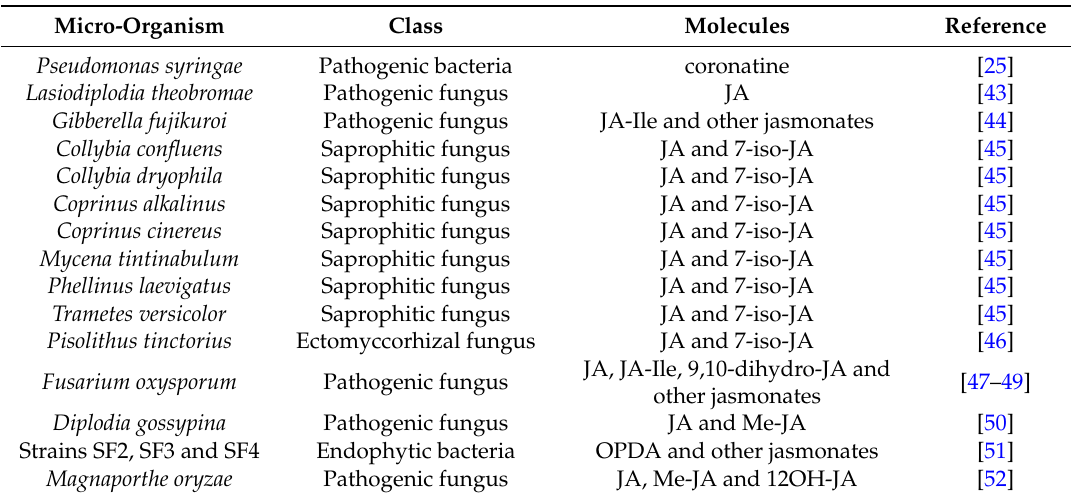
Table 1. Microorganisms able to synthetize jasmonates (JAs) and